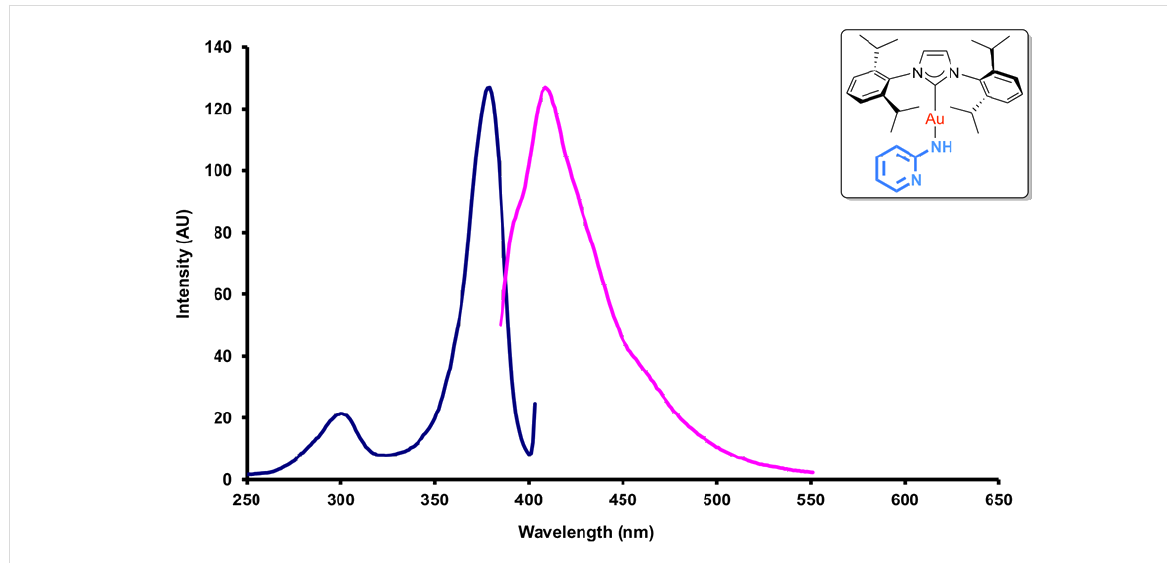
Figure 3: Excitation (blue) and emission (pink) data for complex 3 , bearing a 2-pyridine ligand (see inset).